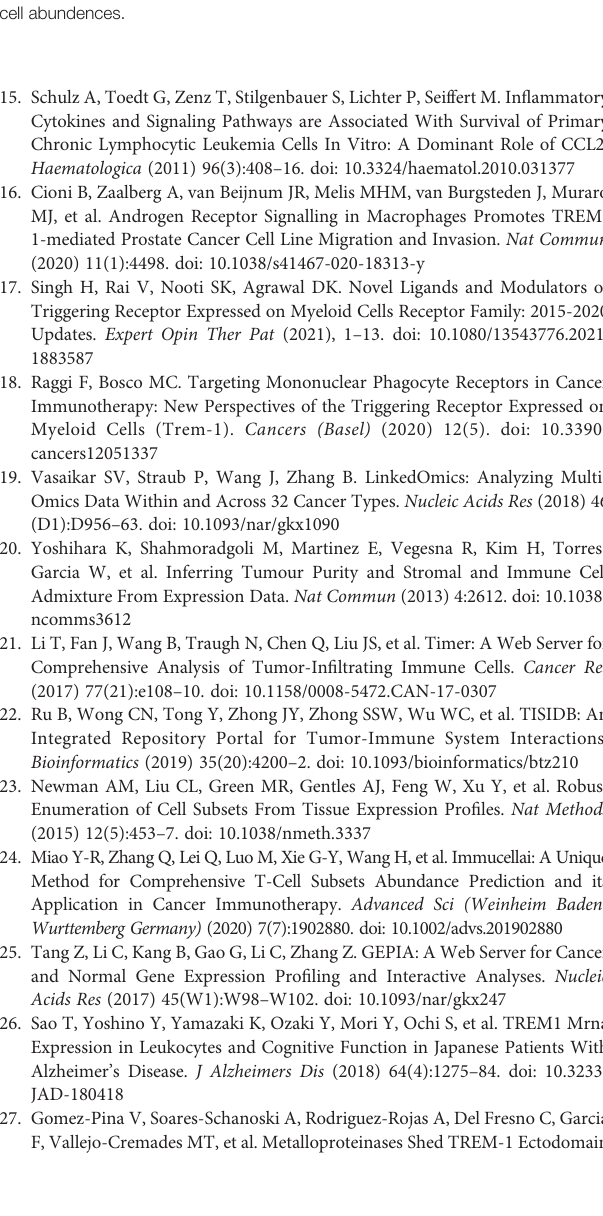
Supplementary Figure 1 | Relationship between TREM-1 expression and gene mutations in PTC. (A) Volcano plot of TREM-1 expression and gene mutations in THCA. (B) Relationship between TREM-1 expression and BRAF mutation. Supplementary Figure 2 | TREM-1 expression is closely related to immunity across human cancers. Correlation analysis between TREM-1 expression and the